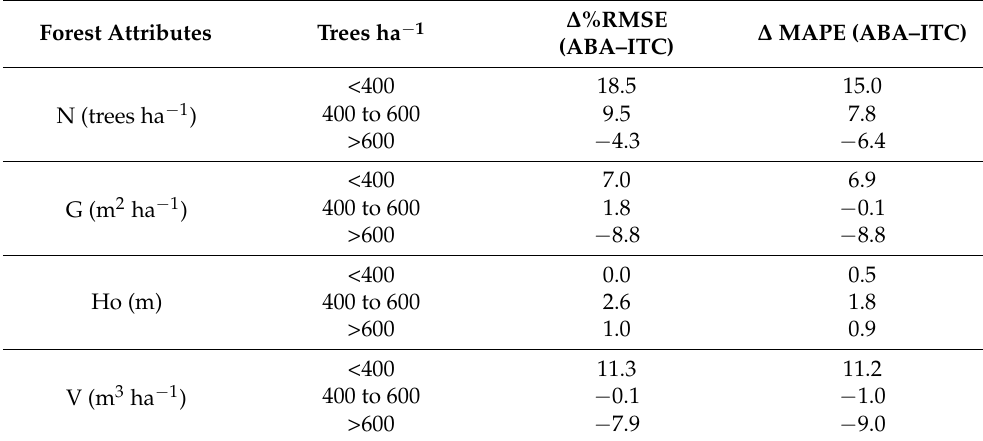
Table 5. Differences in statistical performance between the ABA and ITC models, quantified as ∆ %RMSE (%RMSE ABA–%RMSE ITC) and ∆ MAPE (%MAPE ABA–%MAPE ITC), for each forest attribute and each tree density